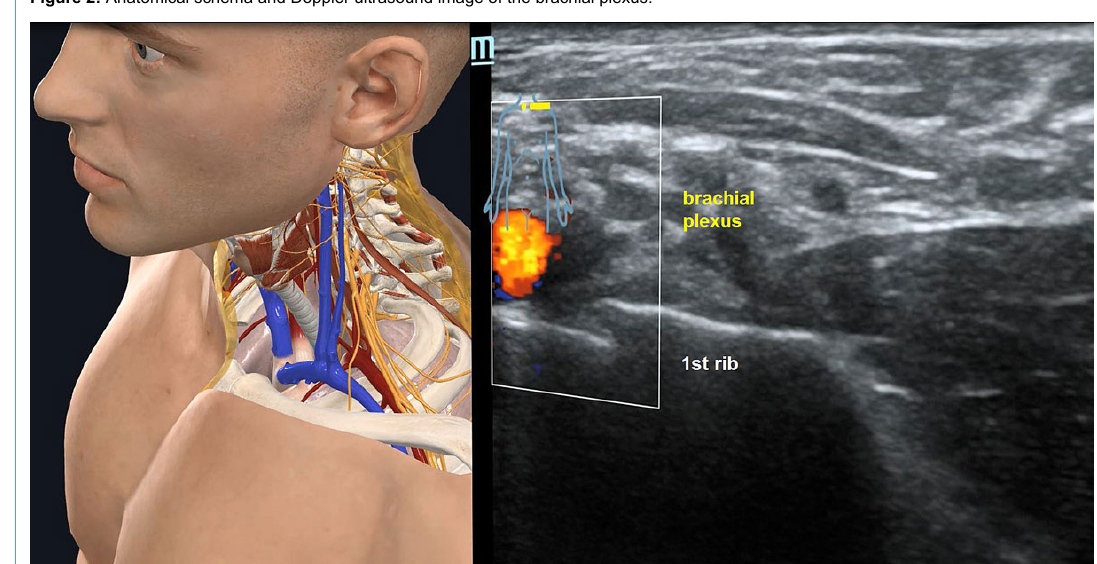
Figure 2: Anatomical schema and Doppler ultrasound image of the brachial